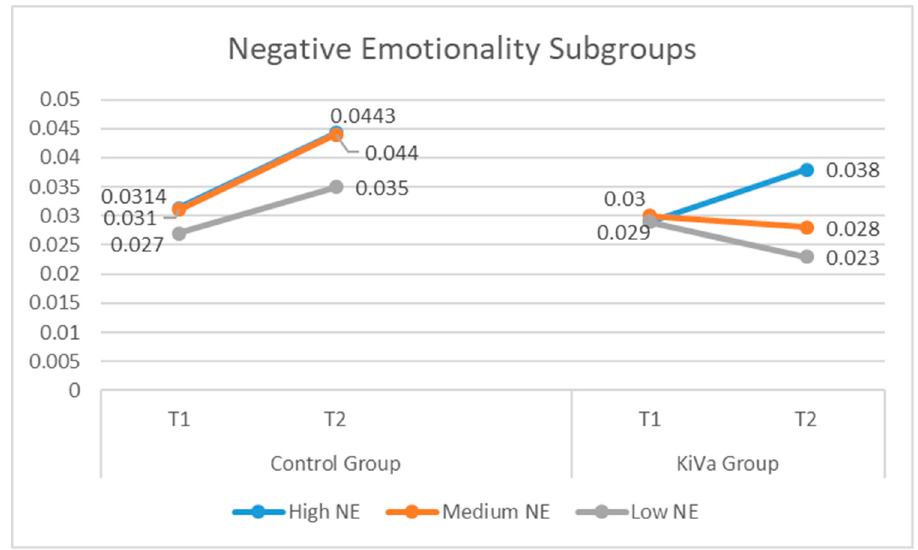
Figure 2. Bullying across time distinguishing between control and KiVa groups, and high, medium, and low levels of negative emotionality.